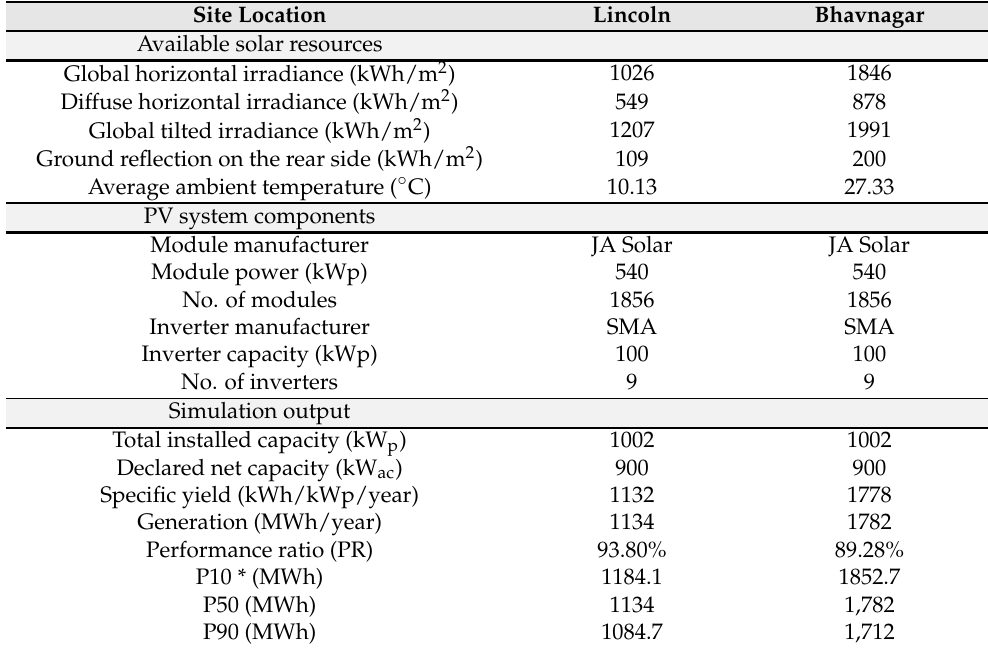
Table 3. Simulation parameters and output for the ground albedo of 0.5.